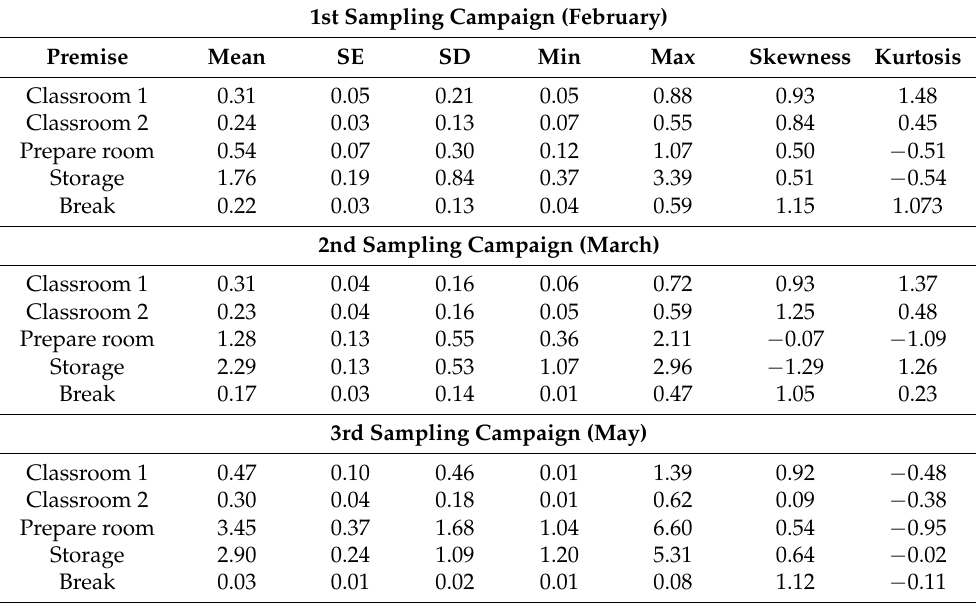
Table 2. FA concentrations during sampling